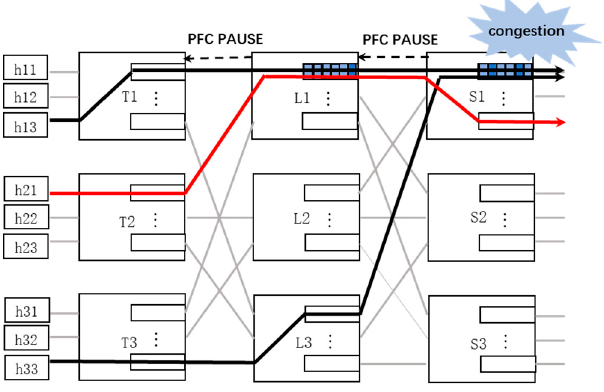
Figure 1. Priority Flow Control ( PFC) Head-of-Line Blocking.